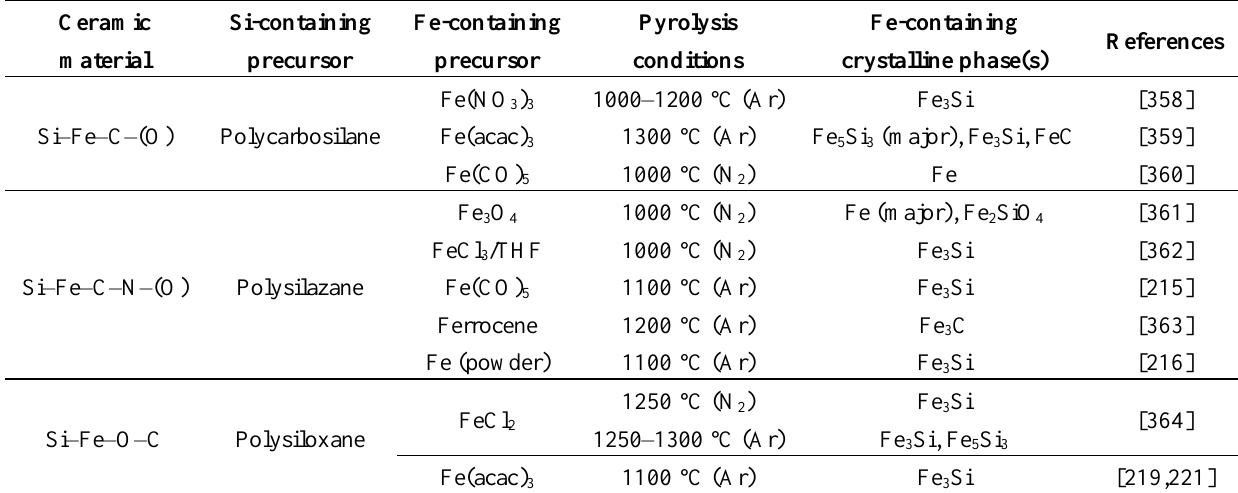
Table 1. Selected examples of Si–Fe–C–X ceramics (X = O, N) derived from iron-modified preceramic